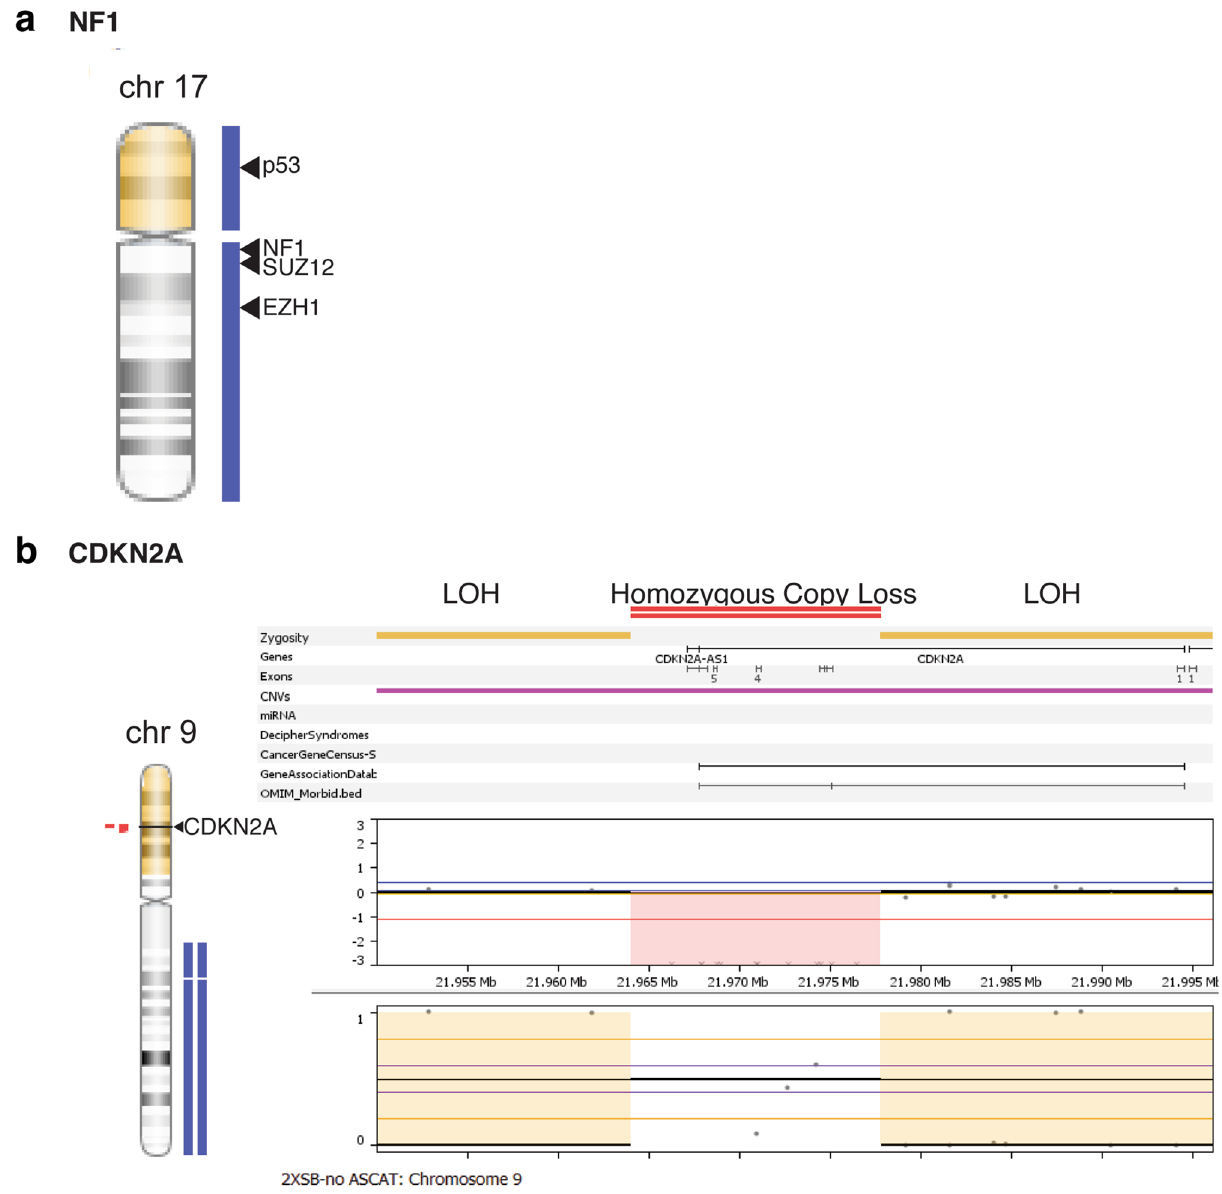
Figure 6. SNP array copy number analysis of the NF1 ( a ) and CDKN2A ( b ) genes in 2XSB cells. Although no losses are evident in NF1 , homozygous deletions are present in CDKN2A